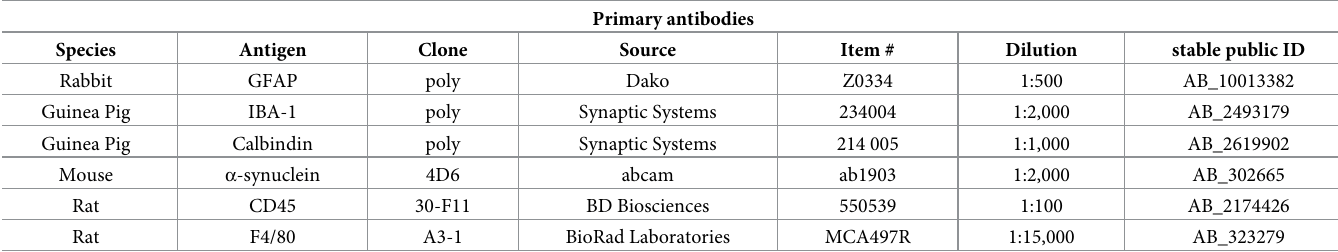
Table 1. List of primary antibodies used for histological